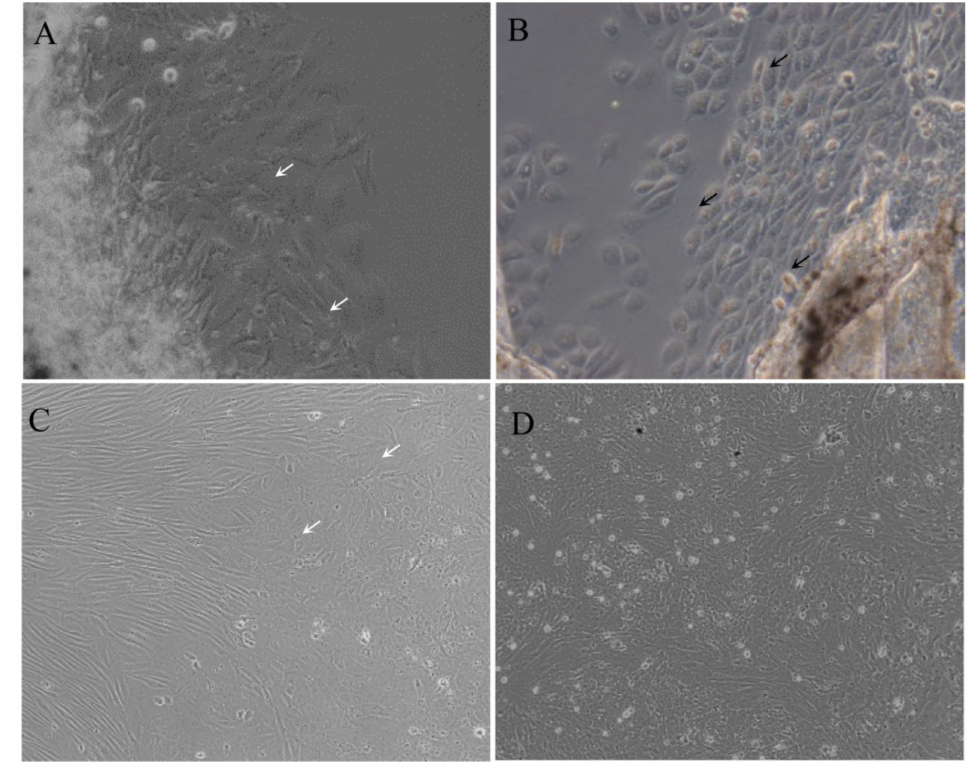
Figure 1. Morphology of MsF cells at different passages. Cells at primary culture ( A , B ), passage 10 ( C ), and passage 50 ( D ) were photographed, respectively. Black and white arrows indicate the epithelial-like and fibroblast-like cells,